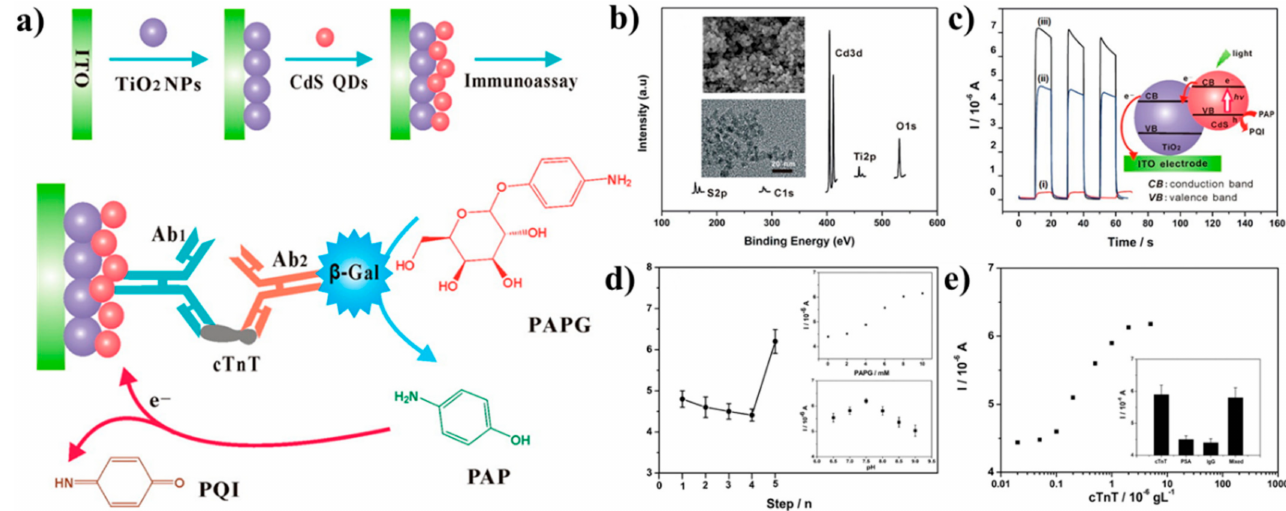
Figure 1. ( a ) Schematics of the photoelectrochemical immunoassay for the detection of cTnT using the β - galactosidase tags. ( b ) XPS spectrum of the CdS QDs/TiO 2 NPs electrode (the inset above shows the SEM image of the TiO 2 NPs film and below shows the TEM image of the CdS QDs). ( c ) Photoelectrochemical responses of the TiO 2 NPs electrode (i), after loading with the CdS QDs (ii), and in the presence of 10 mM PAP (iii). ( d ) Photocurrent response from the CdS QDs/TiO 2 NPs electrode (step 1), the electrode after immobilization with Ab1 and BSA blocking (step 2), after target recognition (step 3), after complexing with Ab2 (step 4), and after incubation in 10 mM PAPG (step 5) (the inset above shows the effect of PAPG on the photocurrent intensity in the presence of 1.0 × 10 − 6 g/mL of cTnT, and the inset below shows the photoelectrochemical response as a function of pH). ( e ) Photocurrent of the immunoassay in the presence of different cTnT concentrations (the inset shows the selectivity of the sensor in the presence of PSA, IgG, and the mixed sample). Reproduced with permission from [21] Copyright © 2020, American Chemical